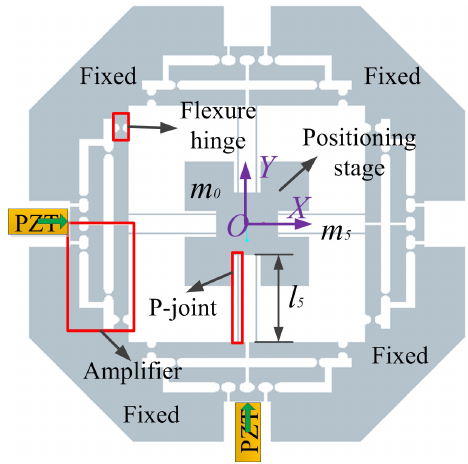
Figure 3. 1-DOF symmetrical mechanism.